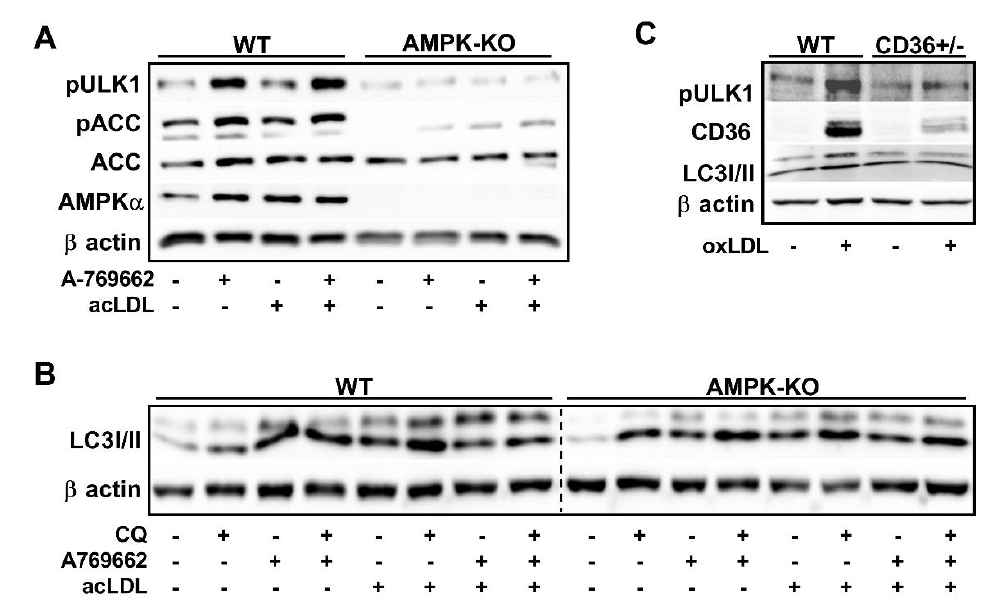
Figure 4. CD36 transmits lipid-induced AMPK activation signal in cultured macrophages. ( A ) Cells were treated with ± acLDL (50 µg/mL) and ± A-769662 (100 µM) for 24 h prior to harvest. ( B ) Macrophages were treated ± AMPK activation (A-769662; 100 µM), autophagy inhibition (chloroquine; 25 µM), and atherogenic lipoproteins (acLDL; 50 µg/mL). ( C ) WT and CD36-deficient macrophages were incubated with oxLDL for 24 h (50 µg/mL). pULK1 (150 kDa), pACC/ACC (260 kDa), pAMPKα/AMPKα (60 kDa), LC3II (14 kDa), CD36 (53 kDa), and β actin (37 kDa). ( A , C ) Total and phosphorylated proteins were determined from duplicate gels. Results are representative of three independent experiments from separate mice.